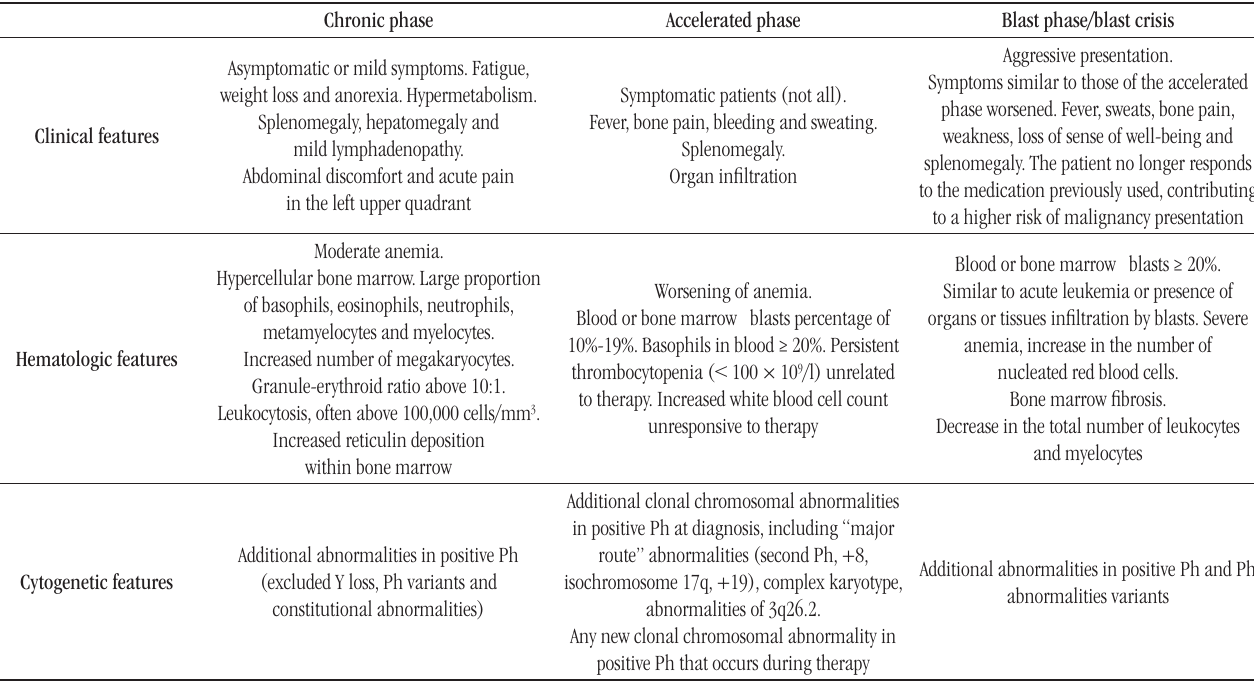
taBLE − Summary of clinical, hematology and cytogenetics features of each phase of CML (2, 3, 39,